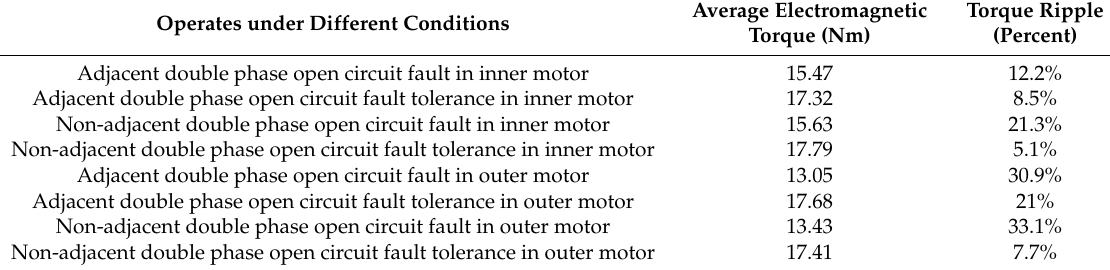
Table 11. The details of average electromagnetic torque and torque-ripple under double phase open circuit fault in one side of motor when machine operates in the parallel driven mode. Operates under Different Conditions